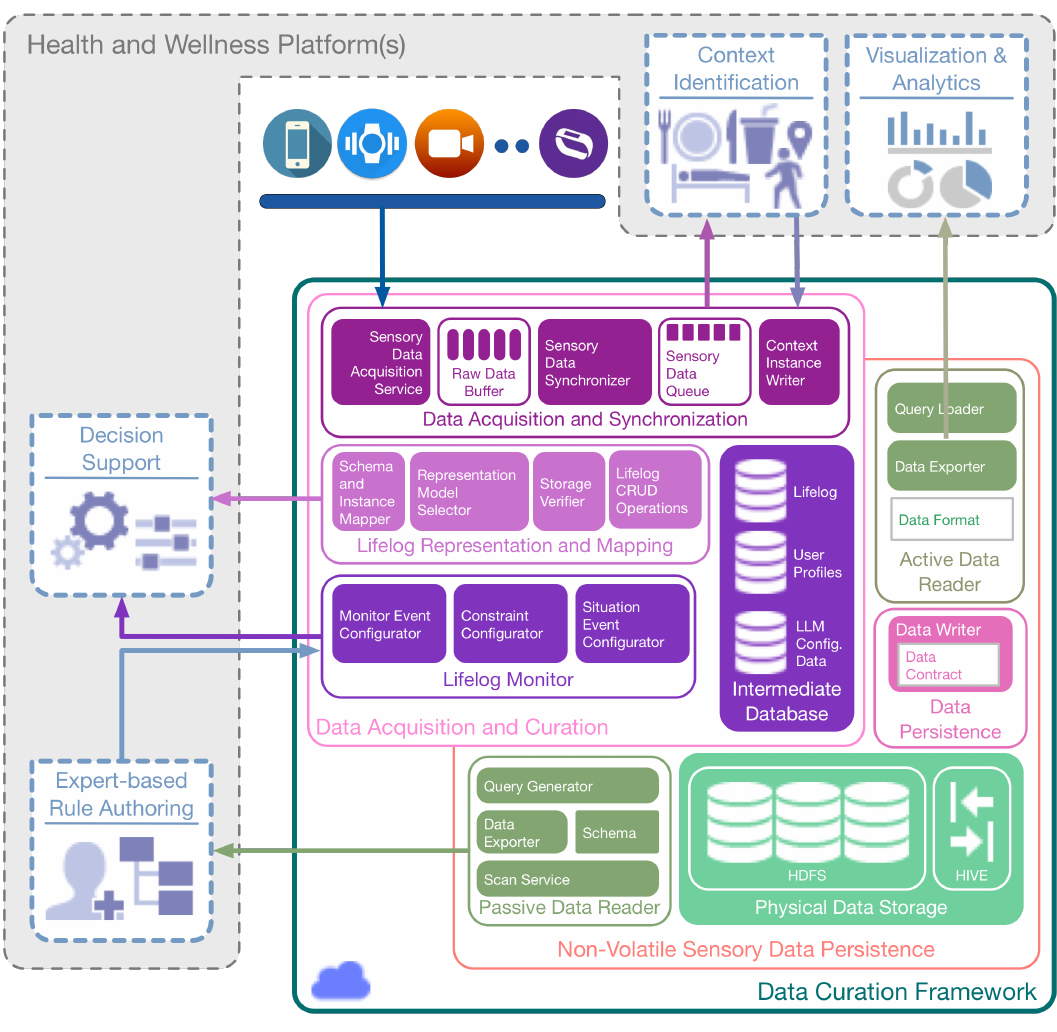
Figure 2. Data curation framework (DCF)